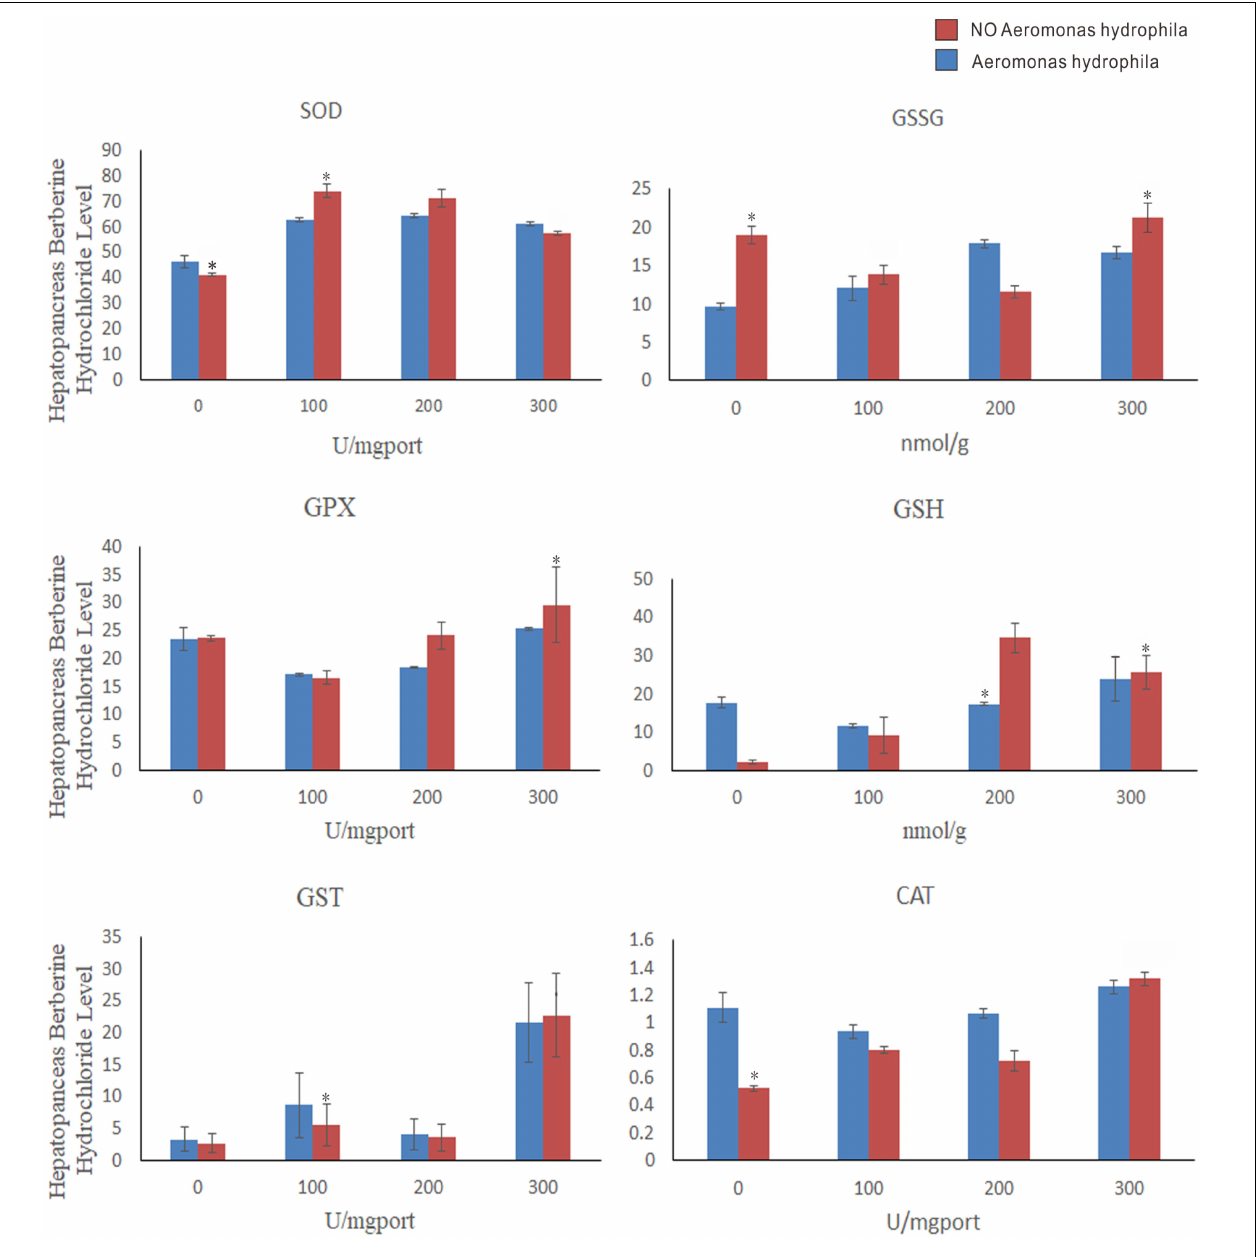
FIGURE 9 | Charybdis japonica (AH) infected with A. hydrophila , crabs immersed in berberine hydrochloride 100 mg/L (BH1), 200 mg/L (BH2), and 300 mg/L berberine hydrochloride (BH3), 100 mg/L berberine hydrochloride and injected with 1 A. hydrophila (BHAH1), 200 mg/L berberine hydrochloride and injected with 10 5 CFU/L A. hydrophila (BHAH2). Crabs immersed in berberine hydrochloride 300 mg/L and injected with A. hydrophila (BHAH3) and control group CK at 10 5 CFU/L. Hepatopancreas were used to measure the enzymes and their contents. Each value represents the mean ± SEM ( n = 4 for A. hydrophila injection group; N = 4 for the control). ∗ Significantly different ( P < 0.05) from control